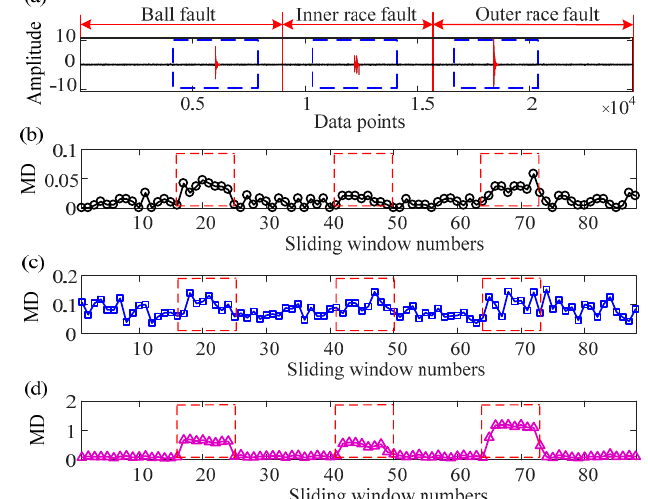
Figure 7. Results of sliding window analysis of LZC, MLZC, and HLZC methods with Minkowski distance (MD): ( a ) the simulated impulsive signal, ( b ) the MD value of MLZC, ( c ) the MD value of LZC, and ( d ) the MD value of HLZC.